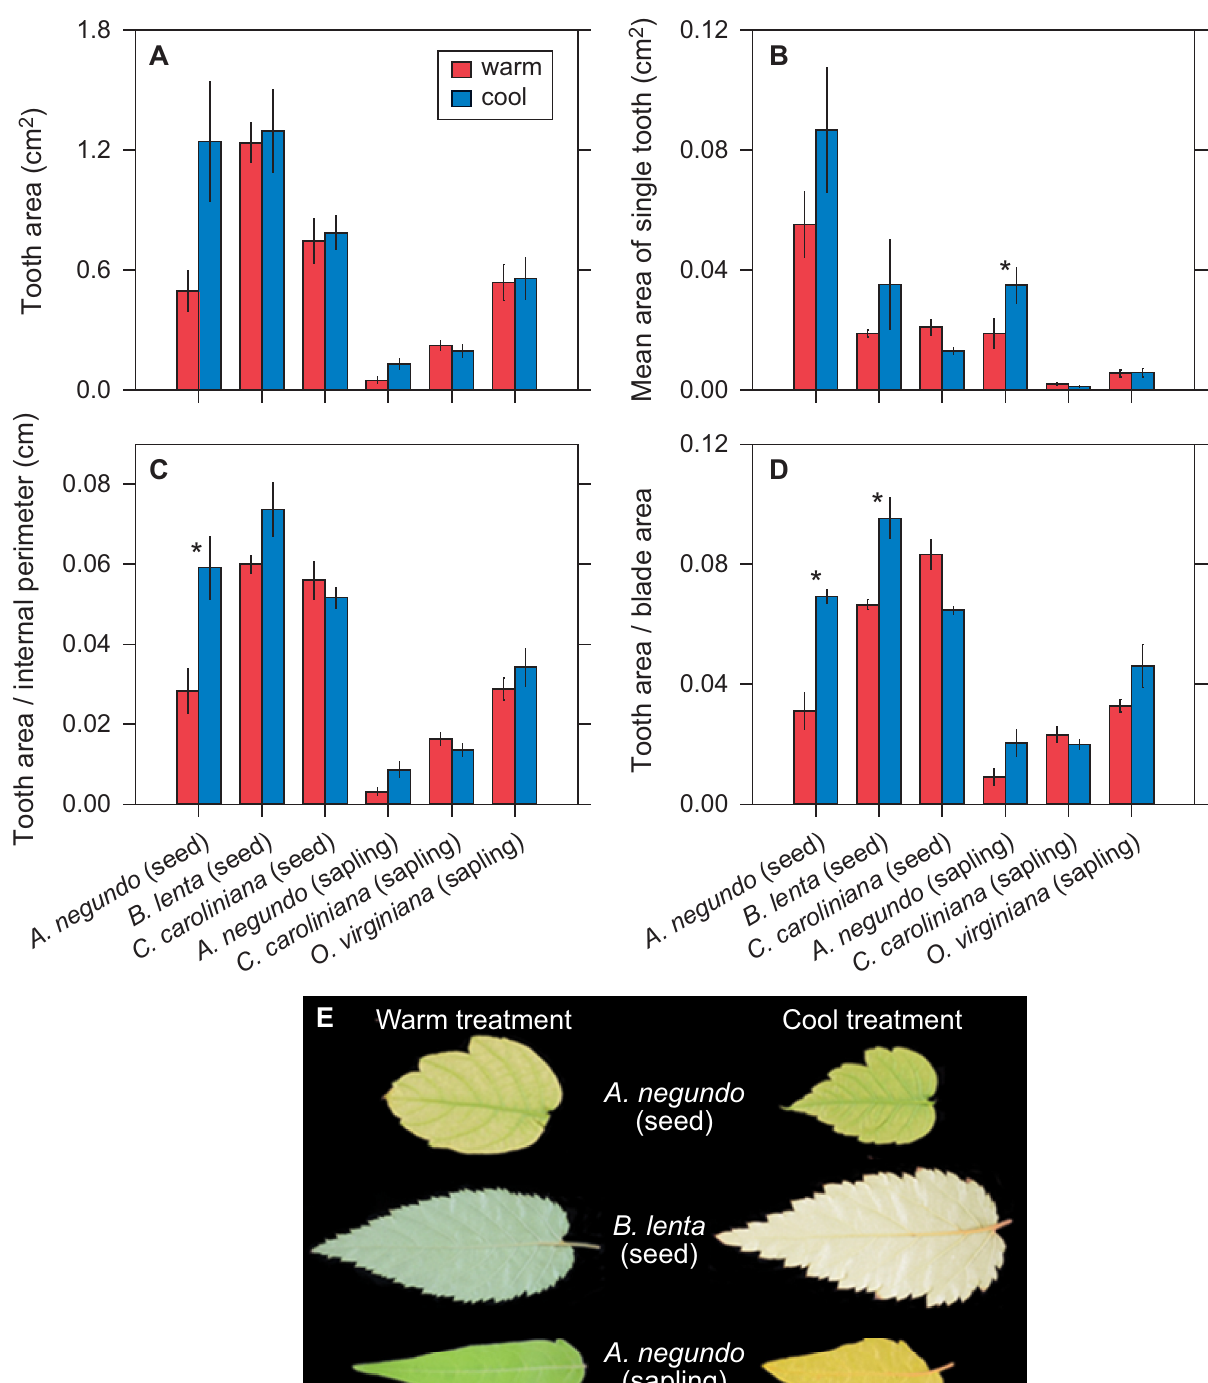
Fig 2. Sensitivity of tooth size variables to temperature. (A-D) Comparisons of the species grown in the growth cabinet experiment for tooth size variables. Values are means ± 1 s.e.m. � indicates a significant difference ( P < 0.05) based on estimated marginal means (see Materials and Methods). Global site-based patterns [6] would predict higher values in the cool treatment for all variables. (E) Representative leaves from species in this experiment that show significant differences in tooth size between the two treatments. Scale bar = 1 cm.